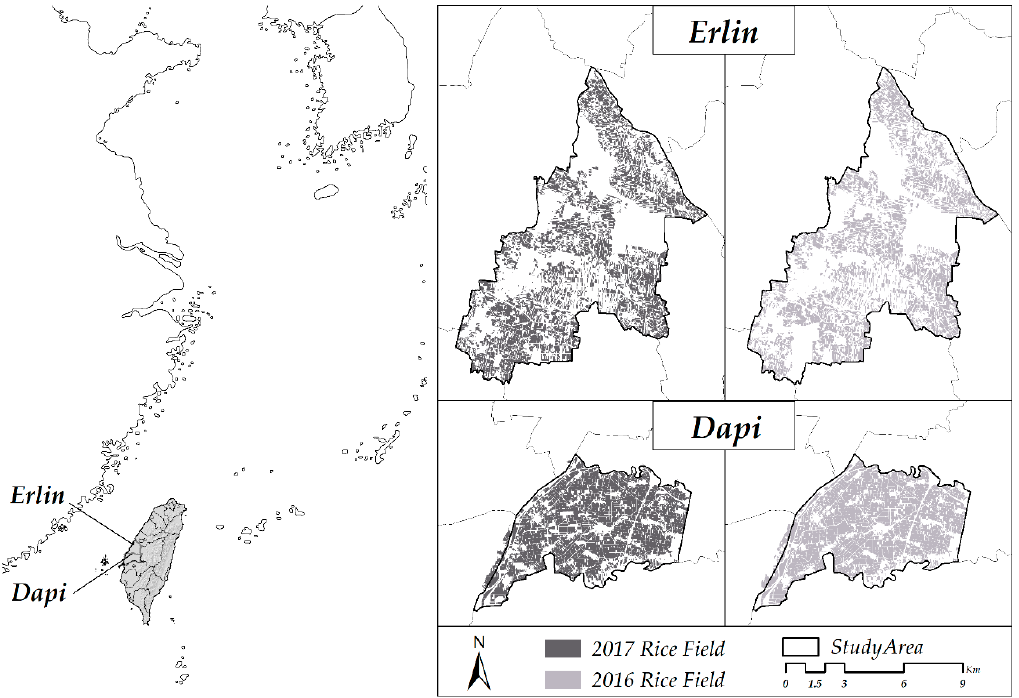
Figure 1. Study area and rice field distribution maps.